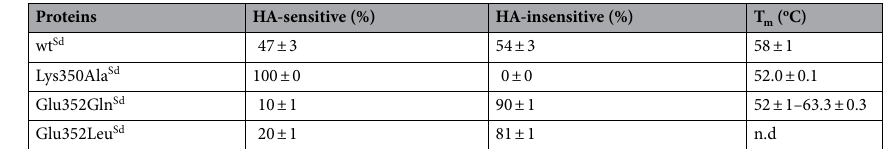
Table 1. Acylation status and thermal stability of wild type and mutant Sd proteins. The fully acylated Sd proteins were treated with hydroxylamine (HA) and the reaction mixtures were analyzed by LC–MS. HA-sensitive and HA-insensitive correspond to the fraction of the protein that reacted or did not react with hydroxylamine, respectively. The melting temperature (T m ) of the different proteins has been measured in a Fluorescence Thermal Shift Assay. n.d. not determined (a T m could not be accurately determined for the two Sd forms present in the Glu352Leu Sd preparations). Averages and standard errors are given (n ≥